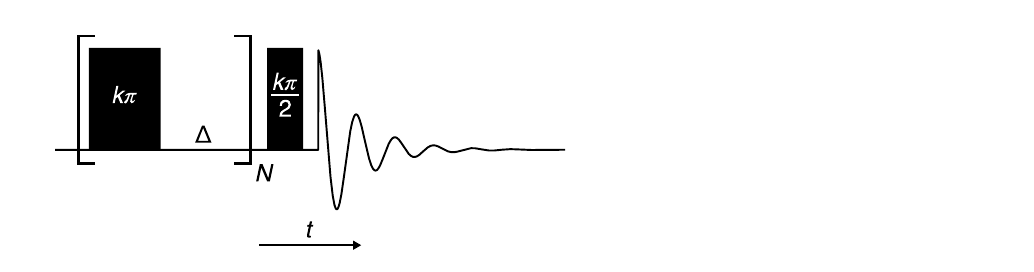
Figure 2. Timing diagram for the Slice Microscopy in Conductors (SMC) pulse sequence. The sequence consists of a saturating chain of N pulses separated by time delays Δ , followed by a readout pulse. The variable, k , modifies the pulses to control the depth of the selected slice, as detailed further in the main text.